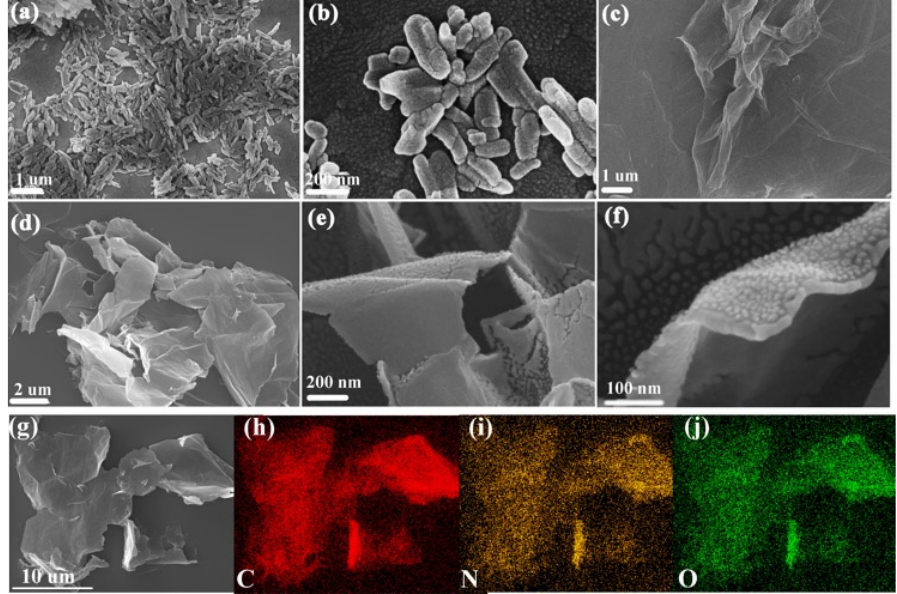
Figure 1. SEM images of PDPP ( a , b ), GO ( c ), and PDPP/GO ( d - g ). The element mapping images of PDPP/GO with C ( h ), N ( i ), and O ( j ) elements.